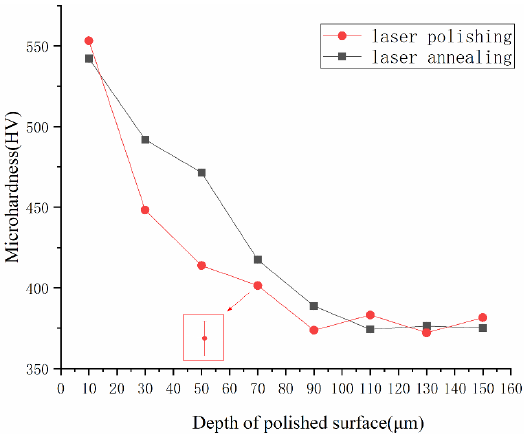
Figure 7. Microhardness of laser polishing and laser annealing.